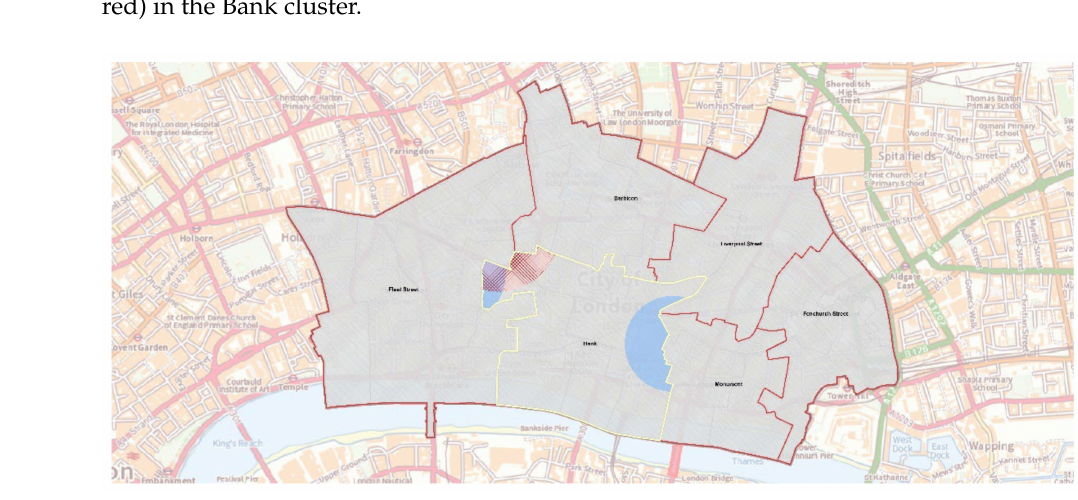
Figure 4. Drug crime hot spots in the Bank cluster for the years 2017 (marked in blue) and 2018 (marked in